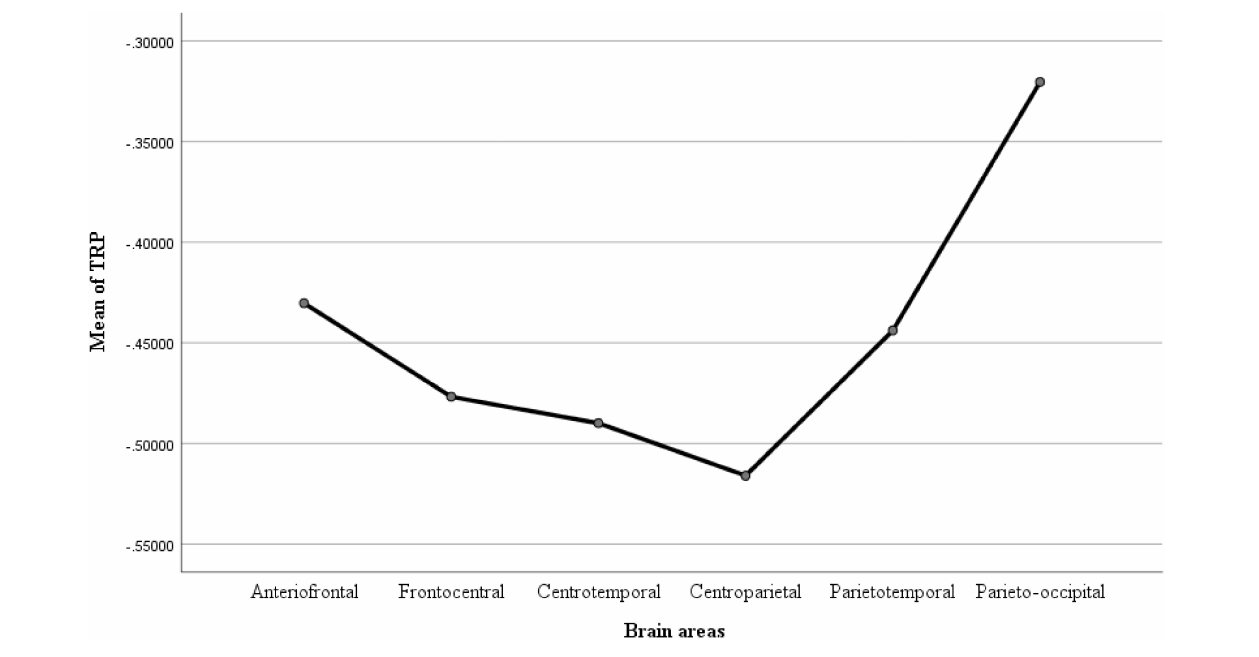
FIGURE 5 | Mean of TRP in different brain